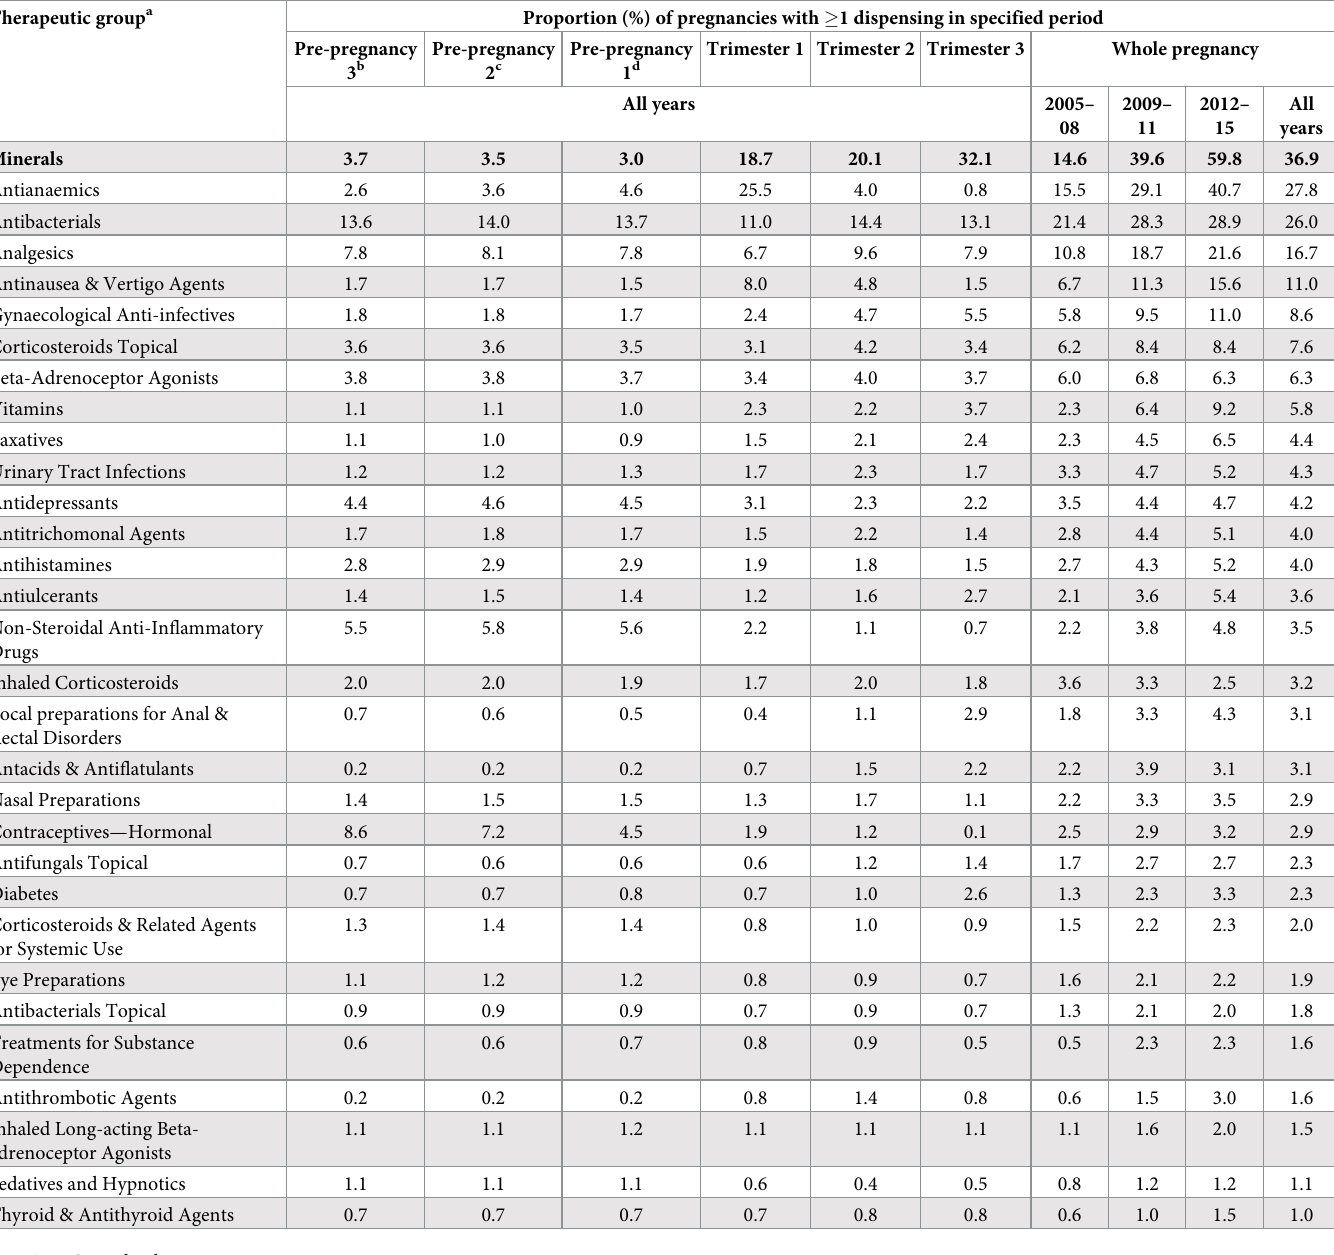
Table 5. Proportion of pregnancies with at least one dispensing from the listed therapeutic groups during the pre-pregnancy and pregnancy periods. Therapeutic group